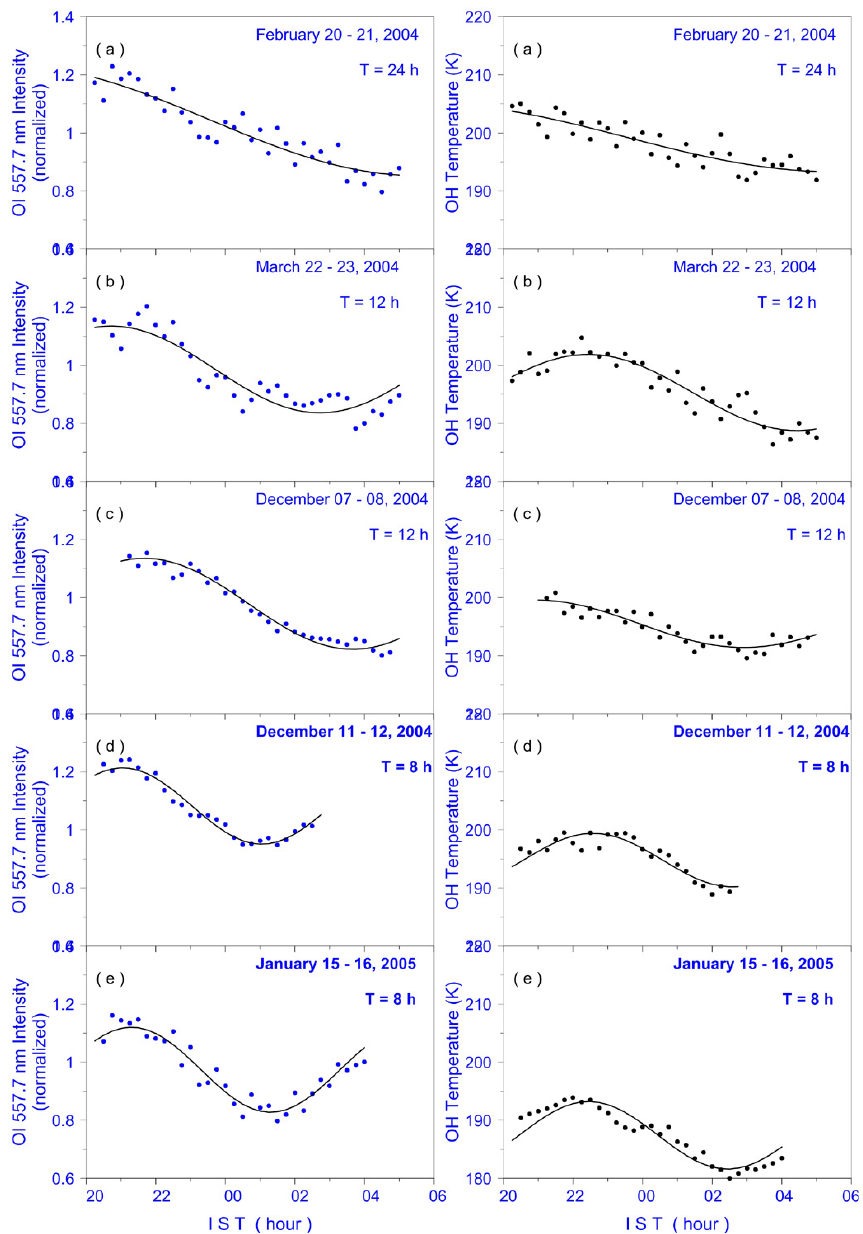
Fig. 5. Examples of tidal oscillations observed in OI 557.7nm emission and OH temperature. The solid curves represent the sinusoidal least square fit (confidence level of 95%) of the form A sin [ ( 2 π/T )(t − φ) ] .